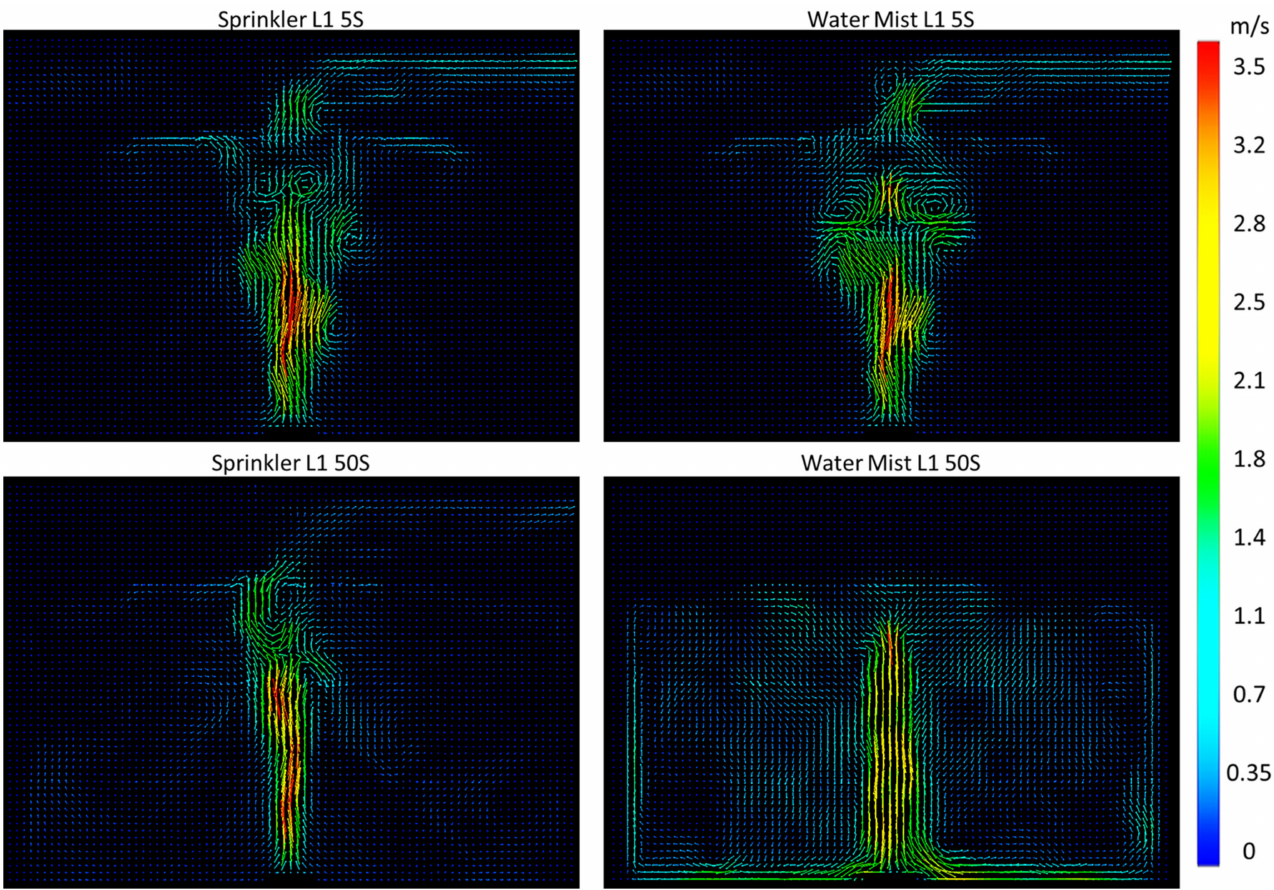
Figure 9. Velocity vector for sprinkler and water mist systems at location 1, before and during fire